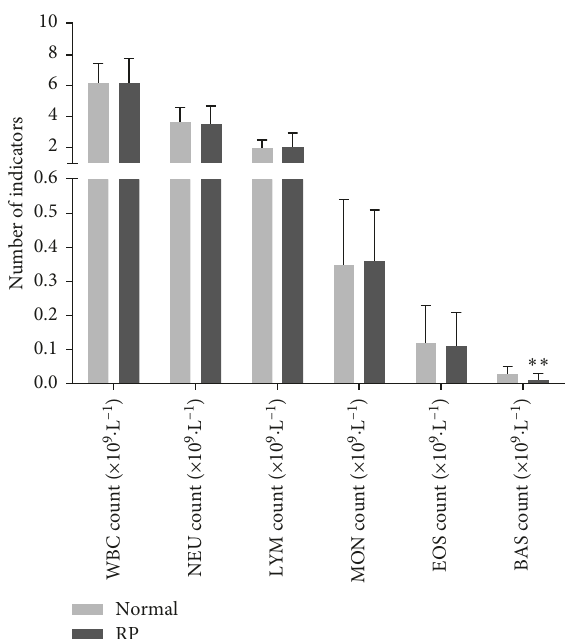
Figure 2: Comparison of WBC indicators between the normal and RP group. Two independent samples T -tests were performed for comparing data of WBC and NEU counts. Two independent samples rank sum test was performed for other data. p < 0 . 05 was considered statistically significant. ∗∗ p < 0 . 01 was considered sta- tistically very significant. Table 3: Comparison of PLTindicators between the normal and RP group.